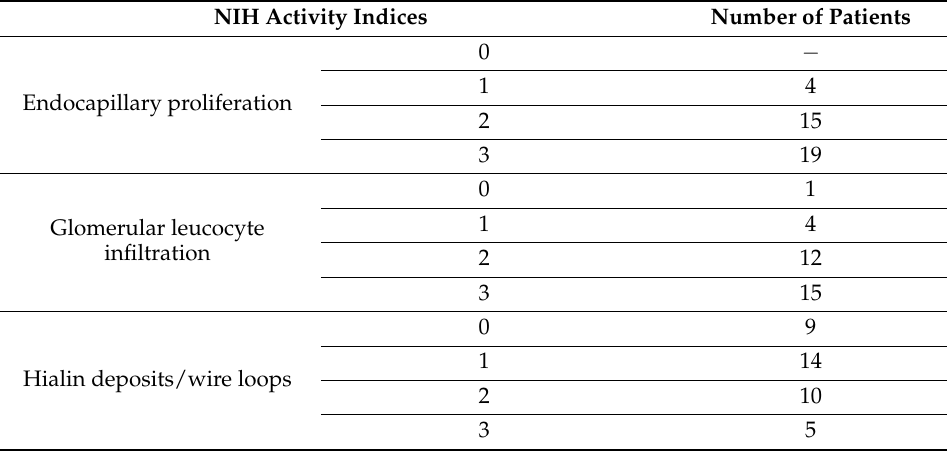
Table 9. Activity and chronicity index in lupus